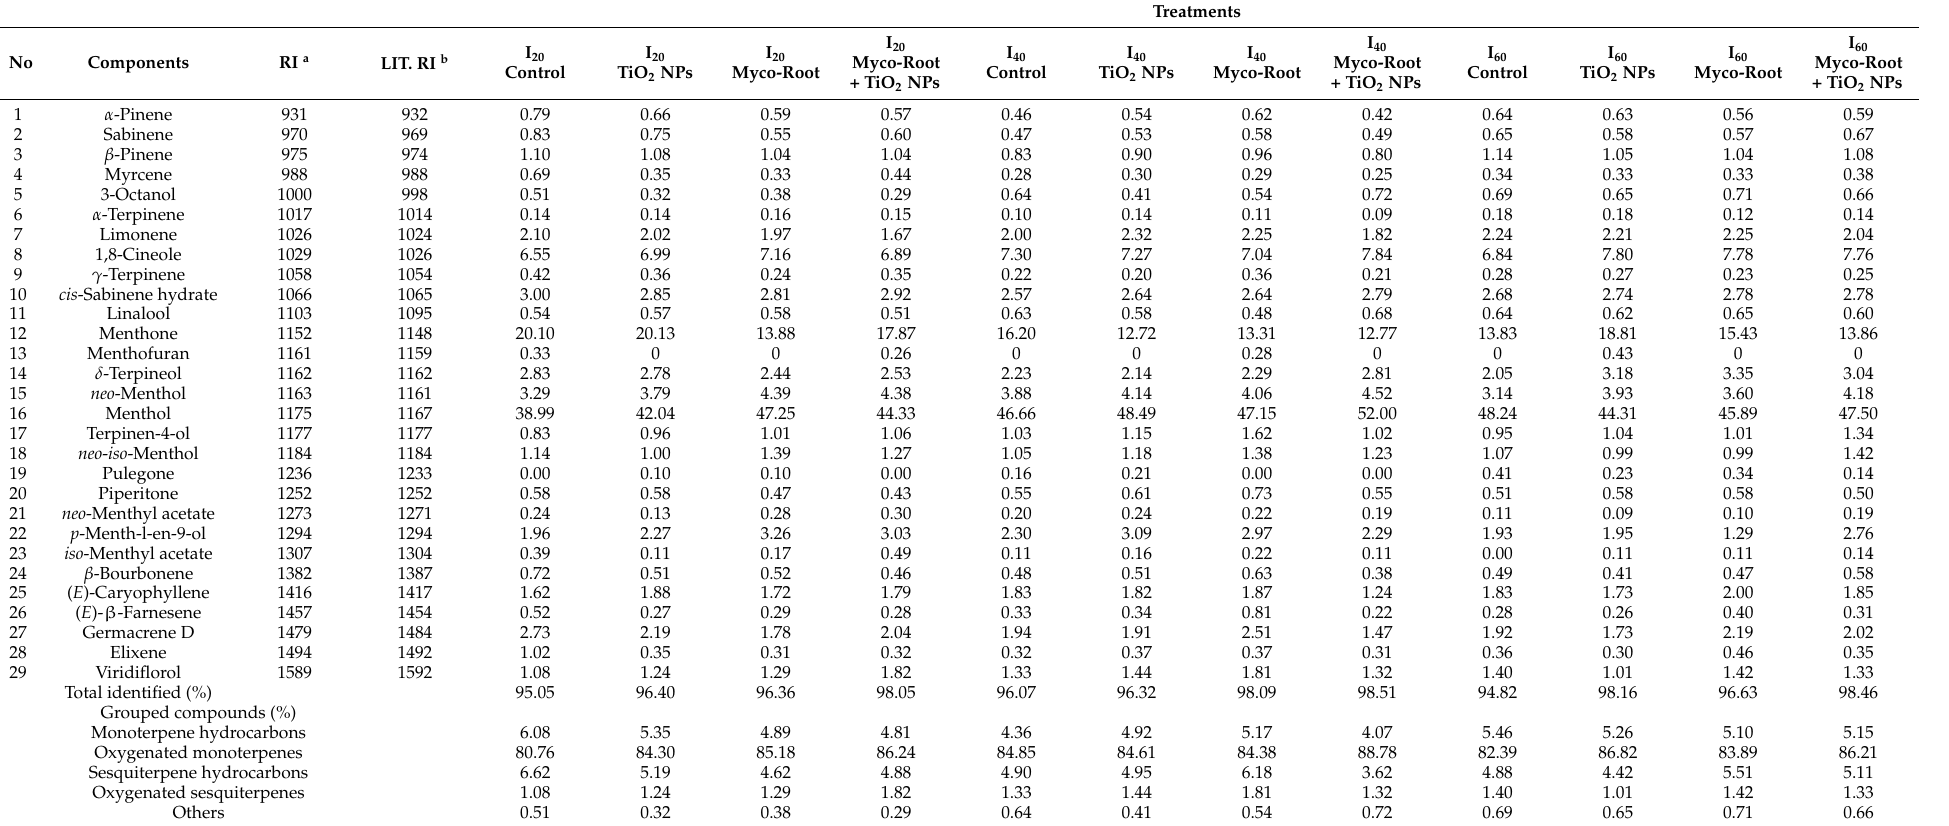
Table 5. The essential oil constituents of peppermint in different irrigation regimes and fertilizers (average of two years).